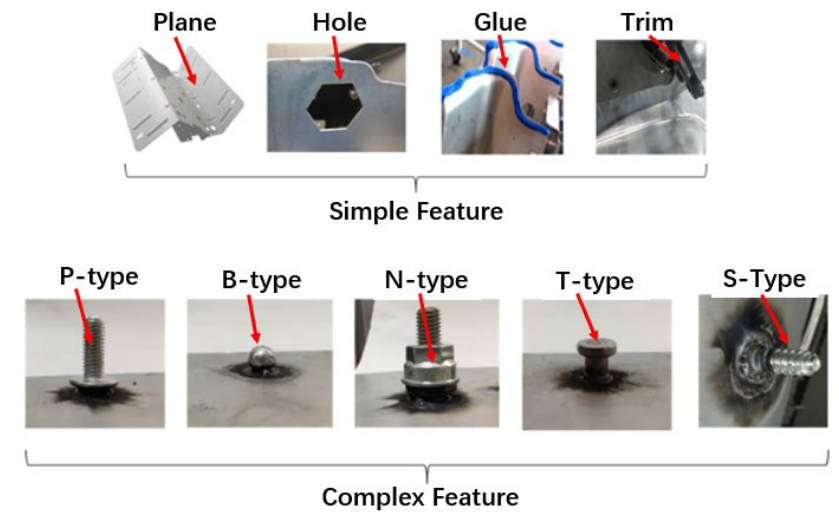
Figure 1. Comparison of simple features and complex features.